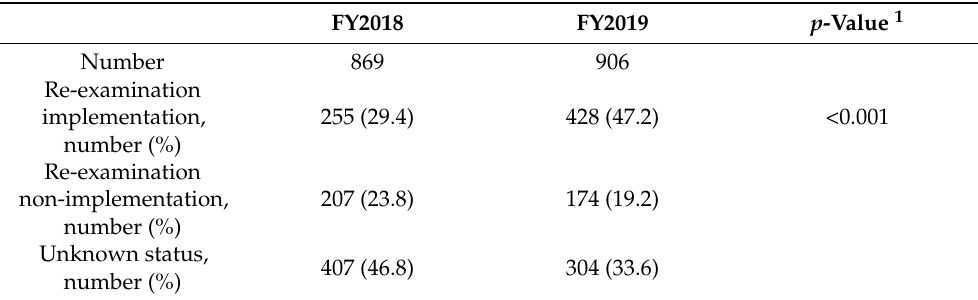
Table 2. CKD re-examination implementation rate among re-examination